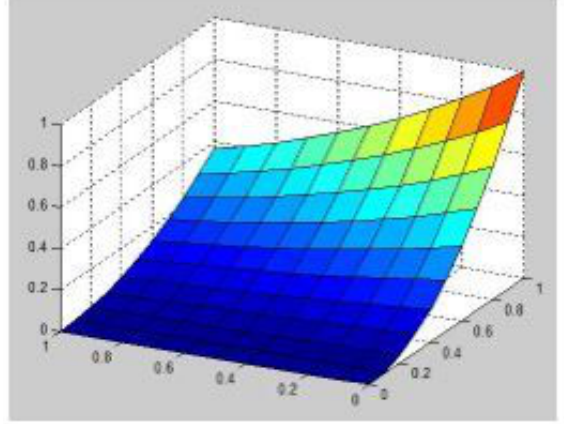
Figure 6: Exact solution